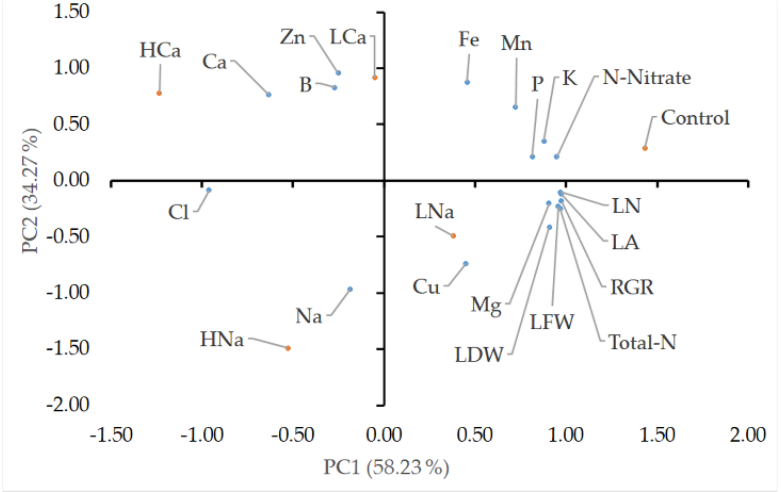
Figure 4. Principal component loading plot (PCA) of agronomical characteristics (LFW: leaf fresh weight, LDW: leaf dry weight, LN: leaf number, LA: leaf area, RGR: relative growth rate) and nutri- ent content (N-Nitrate: Nitrate, Total-N: Leaf Total Kjeldahl nitrogen, Mg: magnesium, K: potas- sium, P: phosphorus, Cu: Copper, Zn: Zinc, Fe: iron, Mn: manganese, B: boron, Ca: calcium, Na: sodium, and Cl: chloride content in dry leaf tissues) of corn salad plant ( Valerianella locusta ) grown in a floating system at harvest stage, as influenced by four salinity treatments (referred to as low and high salinity level) and the salinity source. Control: standard nutrient solution (−0.08 MPa, 20 °C); LNa: low NaCl-salinity (−0.18 MPa, 20 °C); HNa: high NaCl-salinity (−0.28 MPa, 20 °C); LCa: low CaCl 2 -salinity (−0.018 MPa, 20 °C); HCa: high CaCl 2 -salinity (−0.28 MPa, 20 °C). The mean values were used in each situation. Percentage values of the principal components (PC1 and PC2) indicate variation explained by each PC.